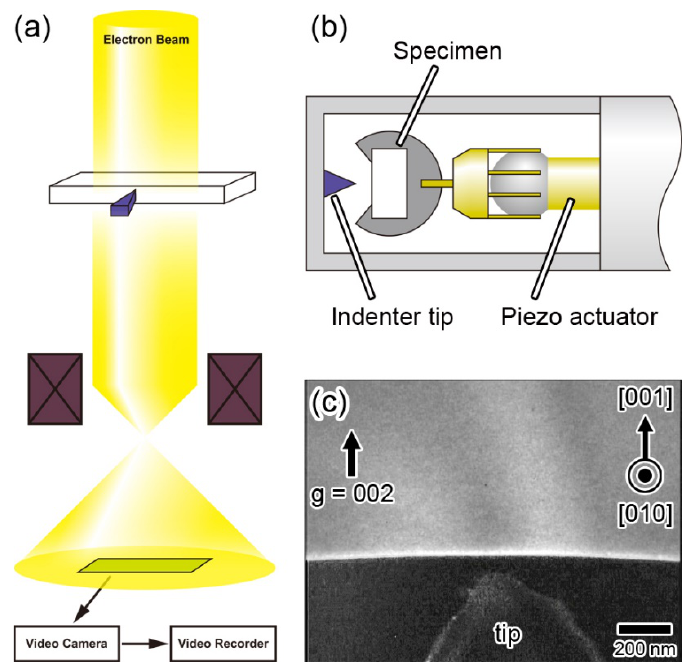
Figure 70. Schematic illustration of the in situ TEM nanoindentation system. ( a ) Overview of the in situ nanoindentation experiment inside TEM; ( b ) Schematic of the TEM nanoindentation holder used in this study; ( c ) Dark-field TEM image ( g = 002) showing the specimen and the indenter tip before indentation. Adapted with permission from Ref. [108].